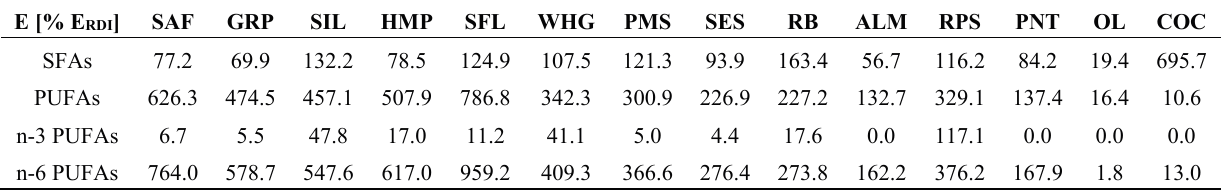
Table 3. Percentage contribution of energy (E) of SFAs, PUFAs, n-3 PUFAs and n-6 PUFAs of vegetable oils to recommended daily intakes for total fat (E RDI —37.7 kJ/g) 1